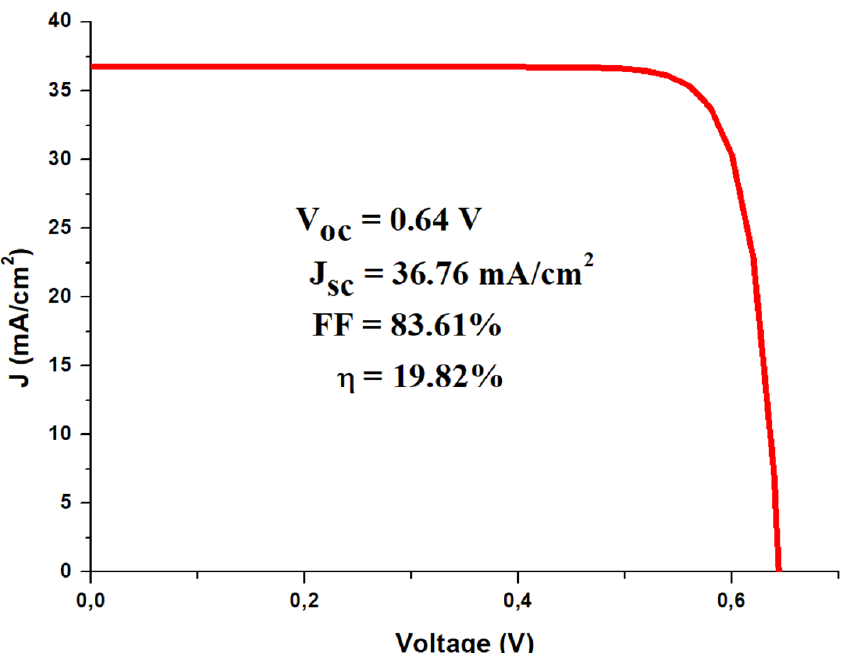
Figure 8. Simulated J-V characteristic of p-Si/n-MoS 2 solar cell, as calculated by SCAPS-1D™ software. The high PCE obtained is comparable to the one obtained for well-proven